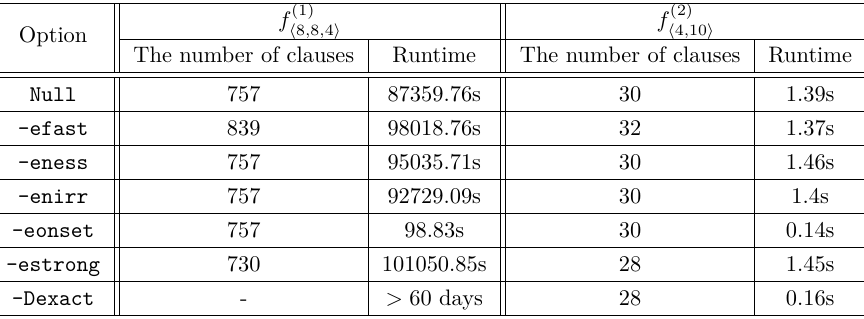
and f (2) . ⟨ 8 , 8 , 4 ⟩ ⟨ 4 , 10 ⟩